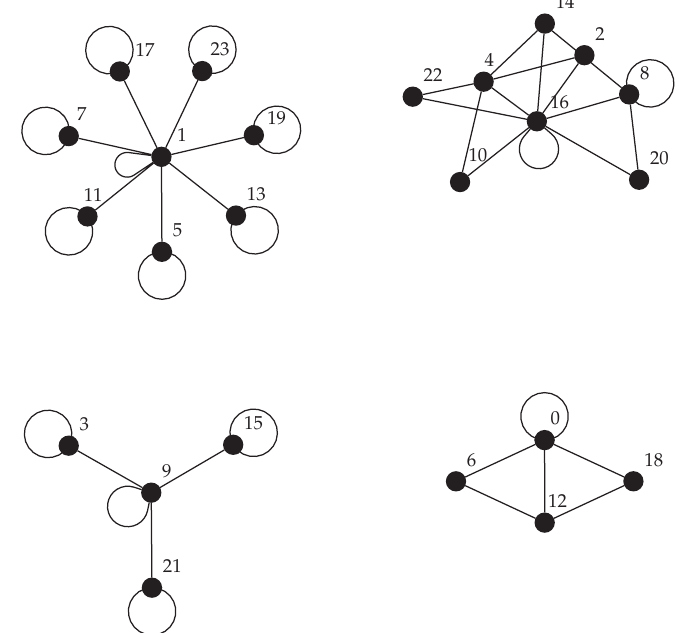
Figure 2: The graph G (cid:2) 24 (cid:3) has 15 nontrivial